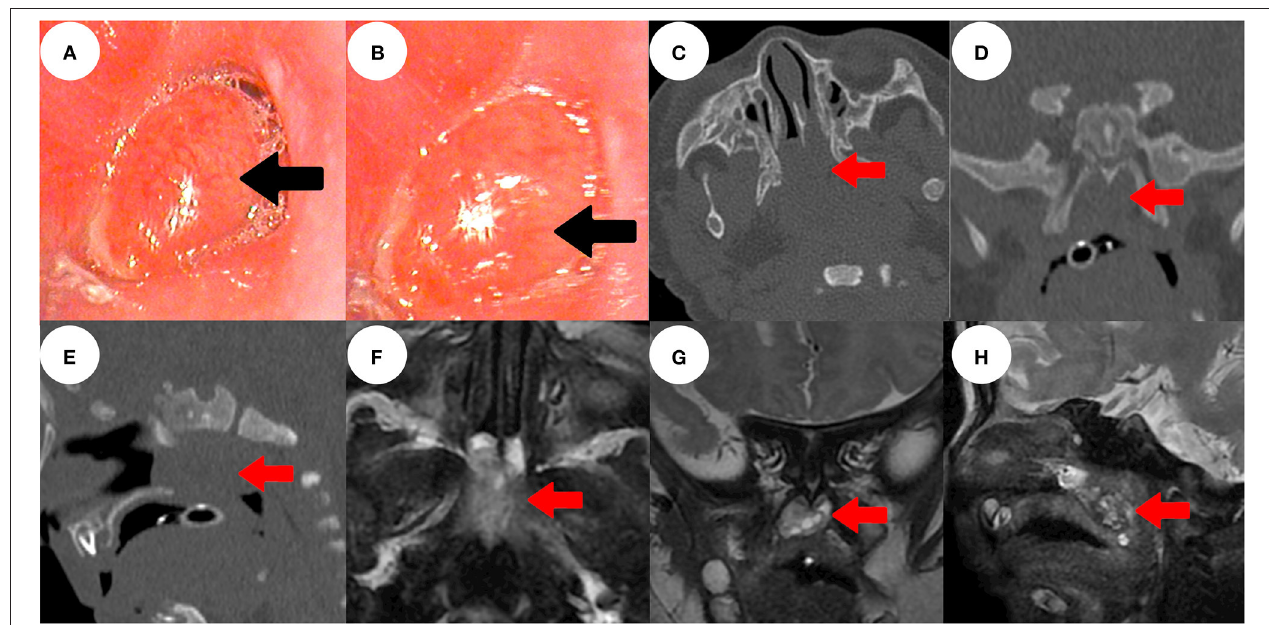
FIGURE 1 | Electronic nasopharyngoscopy showed a red-pink smooth mass with an indistinct base, which almost completely blocked the posterior nostrils (black arrow) bilaterally (A,B) . Sinus computed tomography showed a mass with irregular soft tissue density in the nasopharynx (red arrow) (C–E) . Sinus magnetic resonance imaging revealed that the nasopharyngeal mass had irregular mixed signals (F–H)